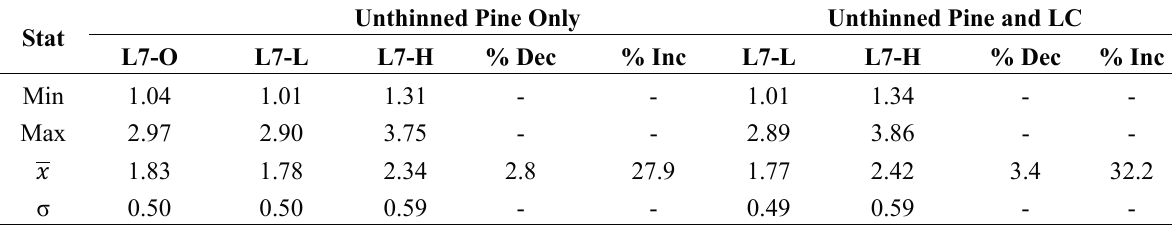
Table 3. Overall change in LAI for the 1 km 2 validation site (Appomattox, Virginia) when integrating variation in the unthinned pine LC class and the uncertainty from differences in